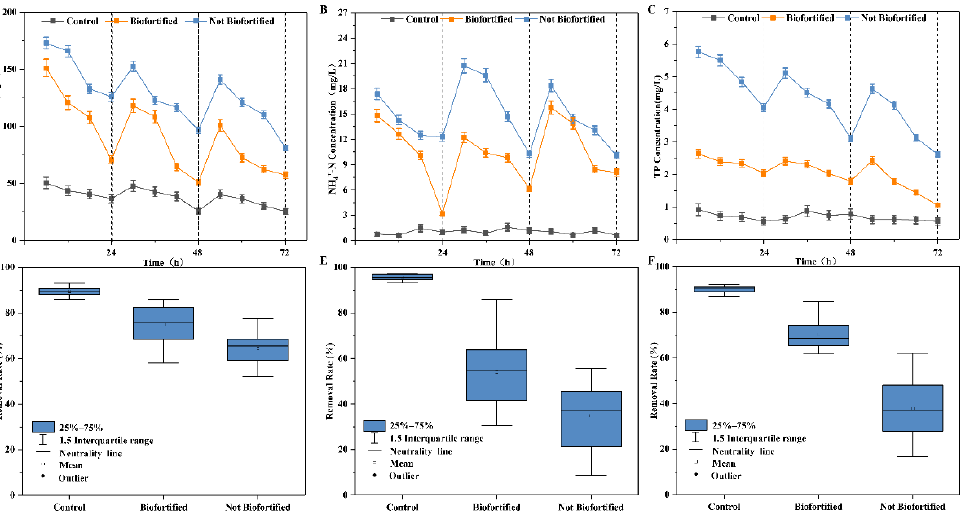
Figure 7. Req-001 bioaugmentation reactor effluent indicators. ( A ) Chemical oxygen demand; ( B ) Ammonia nitrogen; ( C ) Total phosphorus (TP); ( D ) Chemical oxygen demand removal rate; ( E ) Am- monia nitrogen removal rate; ( F ) Total phosphorus removal rate. Control: Activated sludge; Not Biofortified: Addition of bisphenol A (BPA) sludge; Biofortified: Addition of BPA + Req-001 sludge.